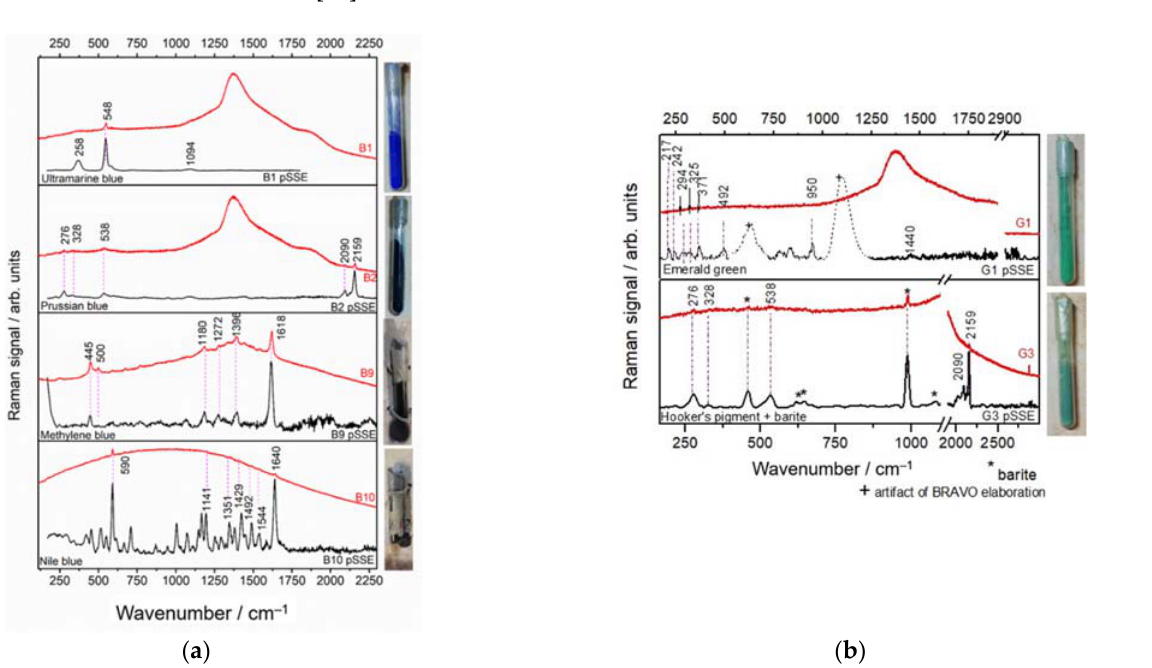
Figure 8. pSSE (black line) and dispersive (red line) RS of examined ( a ) blue (top ‐ to ‐ bottom: ultramarine blue, Prussian blue, Methylene blue, Nile blue); ( b ) green (top ‐ to ‐ bottom: Emerald marine blue, Prussian blue, Methylene blue, Nile blue); ( b ) green (top-to-bottom: Emerald green, Hooker’s green + barite) materials. The considered spectral range is 170–2900 cm − 1 .